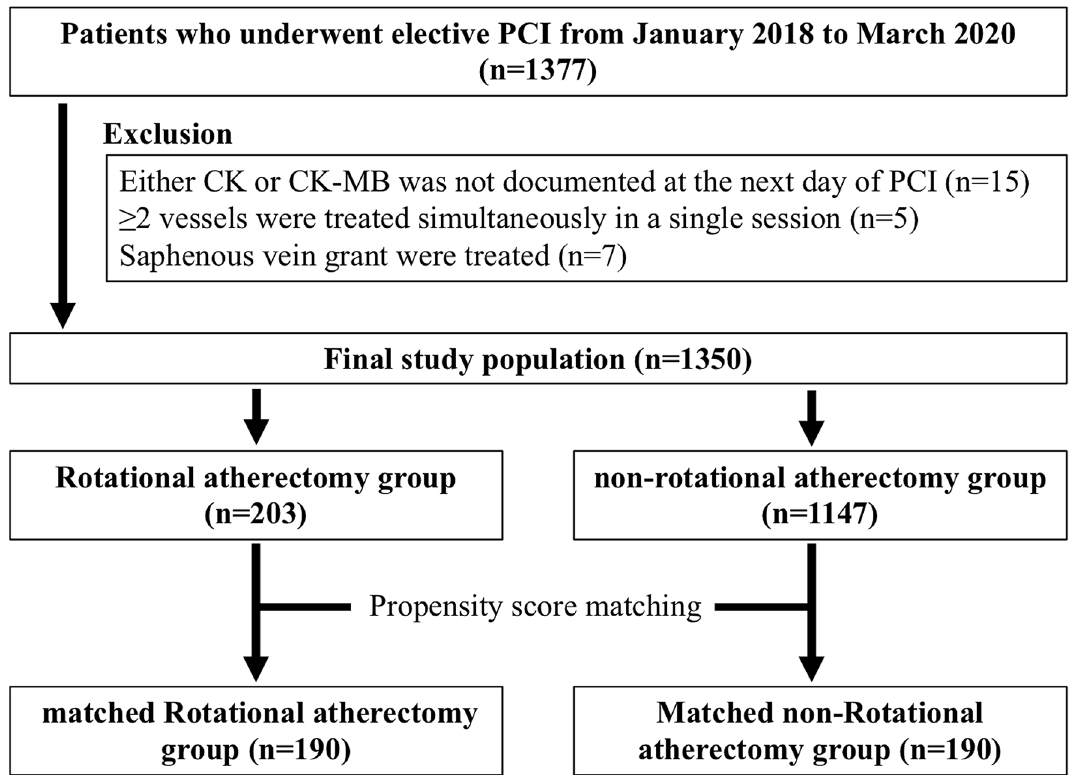
Figure 1. The study flow-chart. PCI = percutaneous coronary intervention; CK = creatinine kinase; CK-MB = creatinine kinase-myocardial band; RA = rotational